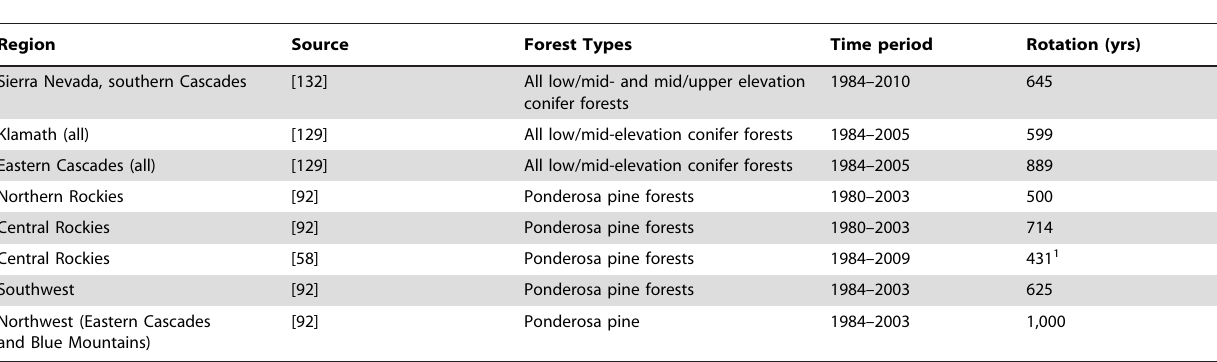
Table 6. Current high-severity fire rotations.